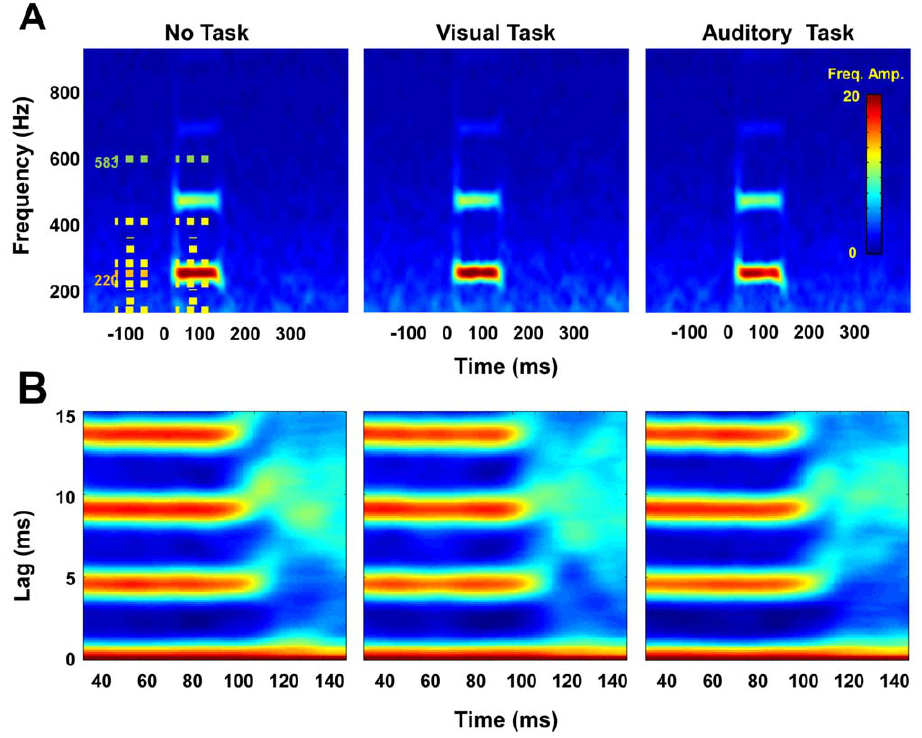
Figure 3. Fourier time-frequency plots for each of the primary conditions. The strongest response occurs primarily within the 220 Hz frequency range, although a short broadboand response is seen at onset and offset in the response spectrogram ( A ). Differences across conditions were limited to only the primary frequency. Dashed lines represent time and frequency periods used for ANOVA; 100–200 Hz (yellow), 210–230 Hz (target range, orange), 240–400 Hz (yellow), and 553–613 Hz (green), pre- and post-stimulus onset. ( B ) shows group average autocorrelelograms reflecting the highly consistent response with this stimulus.